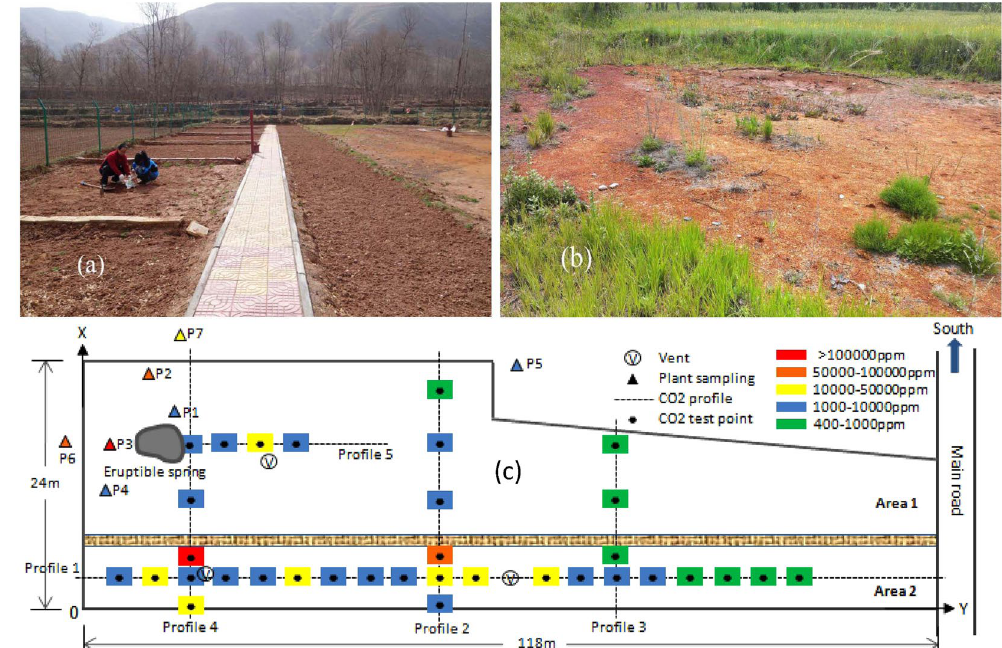
Figure 5. Photographs of the CO 2 Research Field ( a , b ), and the illustration of plant investigation points & CO2 test strategy and concentration ranges ( c